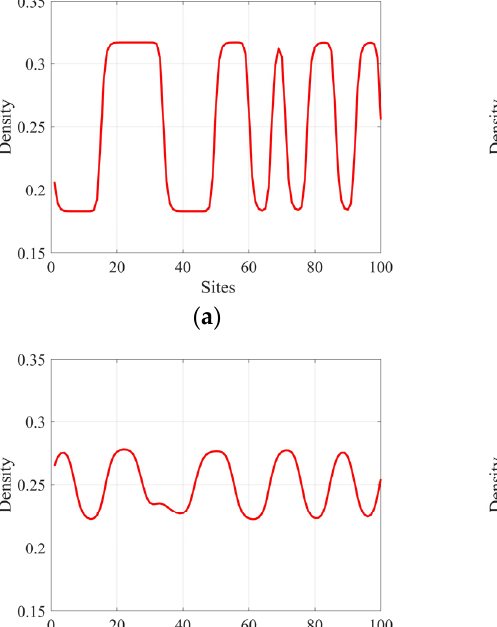
Figure 4. The evolution of the traffic flux for different values of parameter k . ( a )